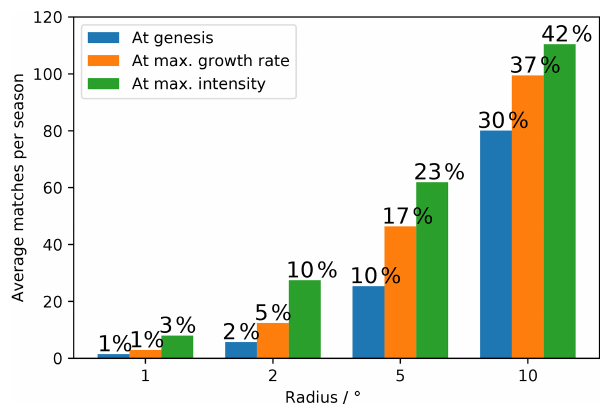
Figure 6. Matches between (all) Arctic cyclones and Arctic-genesis TPVs, with lifetimes ≥ 2d, independently at times of genesis, max- imum growth rate and maximum intensity of the Arctic cyclone for selected spatial overlap radii (note that 1 ◦ is equivalent to 111km in great-circle distance). Values above the bars are the percentage of Arctic cyclones that are matched (of the 10636 Arctic cyclones with lifetimes ≥